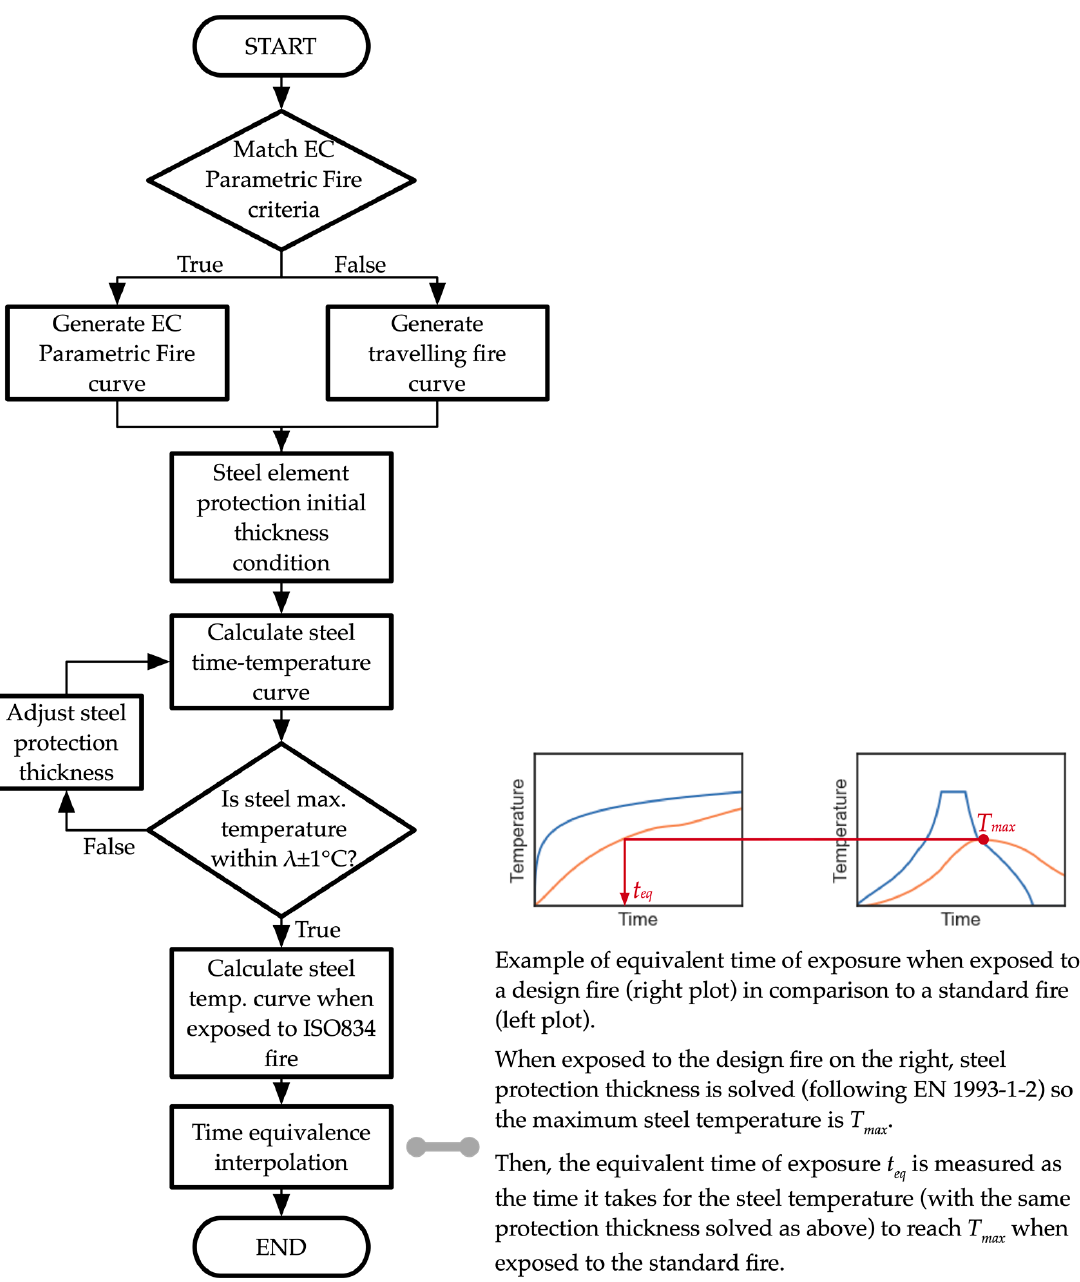
Figure 1. Simplified SFEPRAPY workflow for a single Monte Carlo simulation iteration.